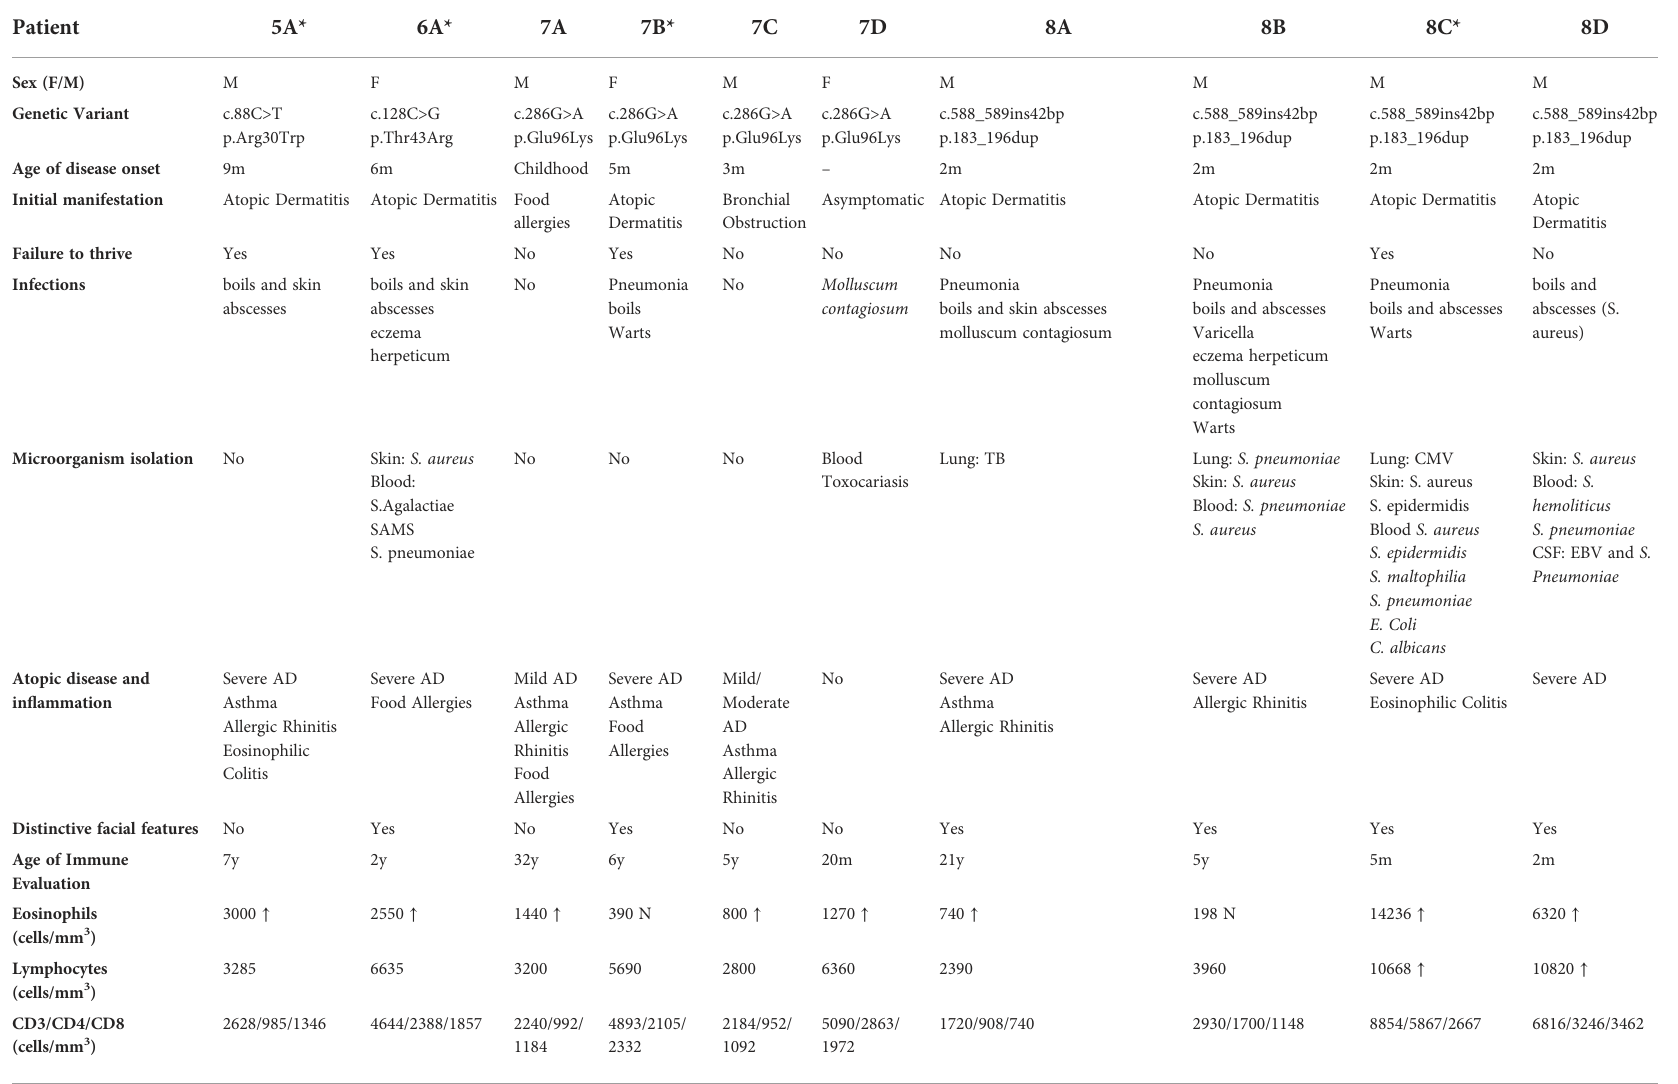
TABLE 2 Demographic, clinical features, immune evaluation, treatment and outcome in CADINS